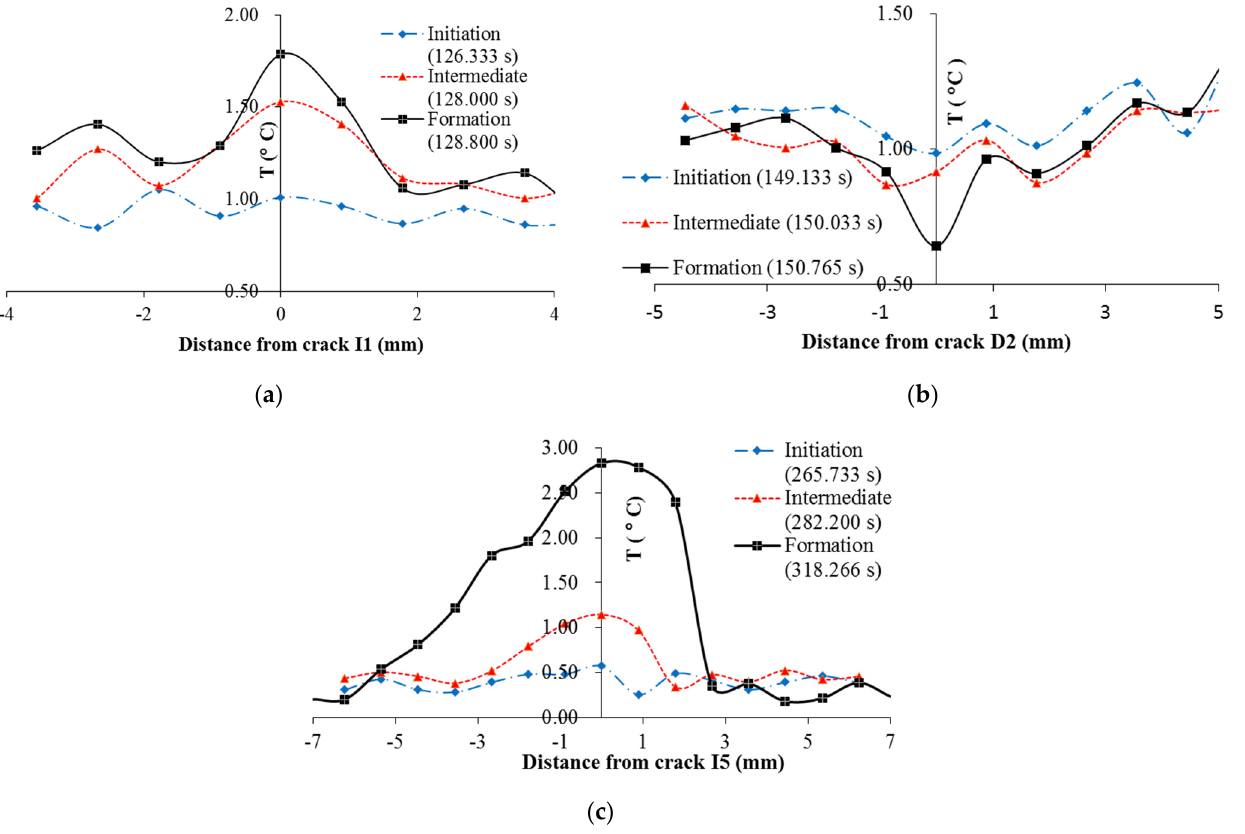
Figure 15. Temperature profile during crack formation: ( a ) crack I1; ( b ) crack D2, and ( c ) crack I5.